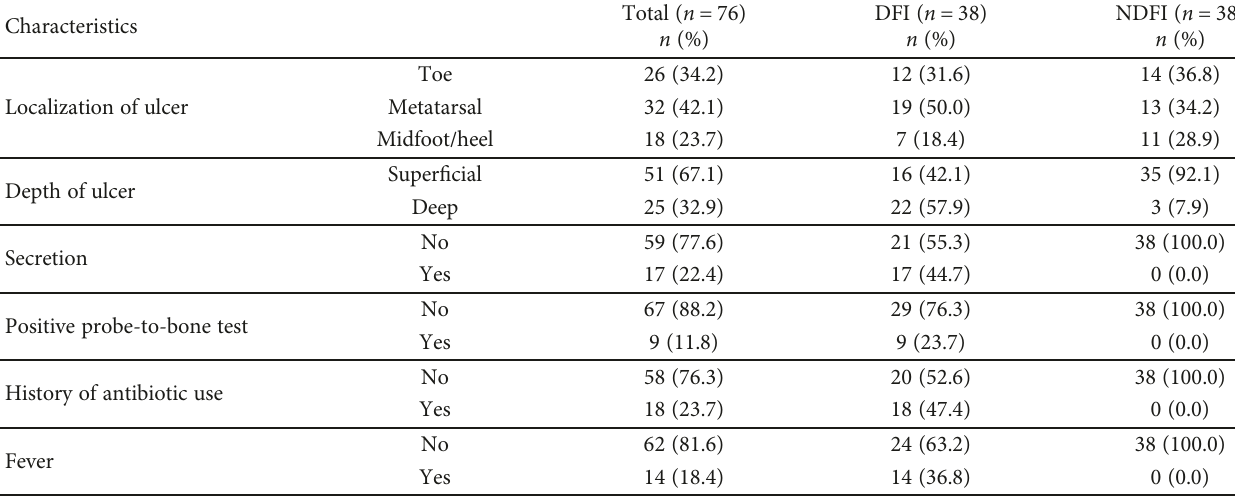
Table 2: Evaluation of wound characteristics in the groups with diabetic ulcer. Characteristics